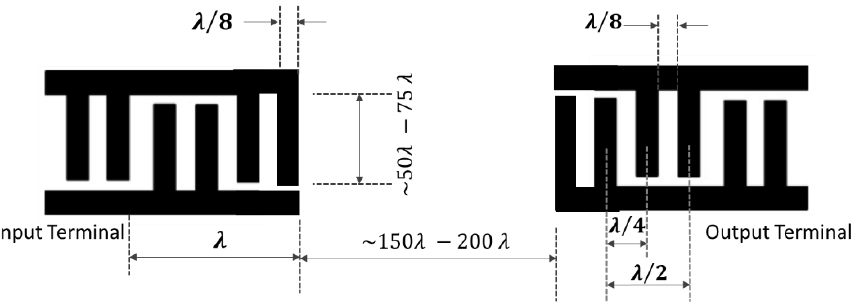
Figure 11. Schematic representation of the split electrode configuration [2].